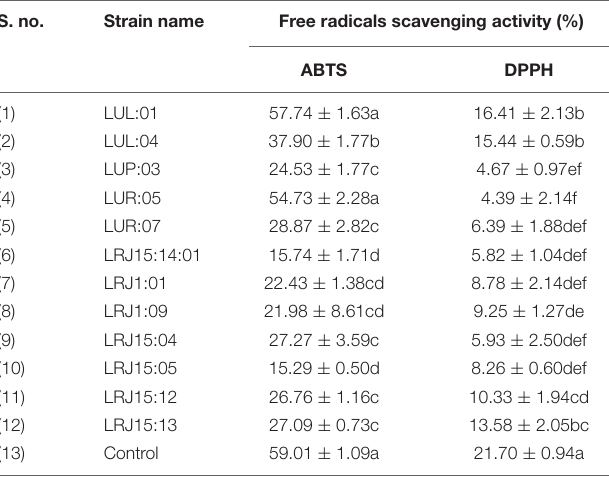
Values are represented as mean ± SD of triplicate analysis. Means in the column with the same superscripts lowercase letters (a–f) are not significantly different as measured by 2-sided Tukey’s–HSD test between replications (p <